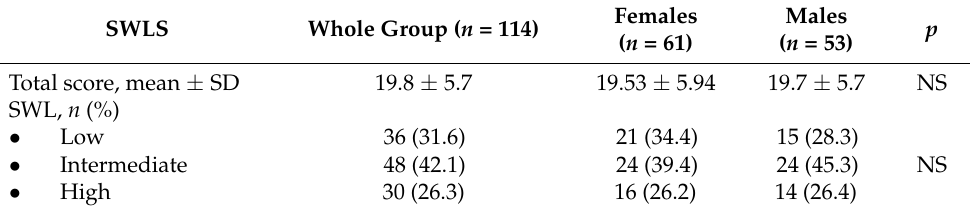
Table 2. Satisfaction with life among patients with hidradenitis suppurativa.